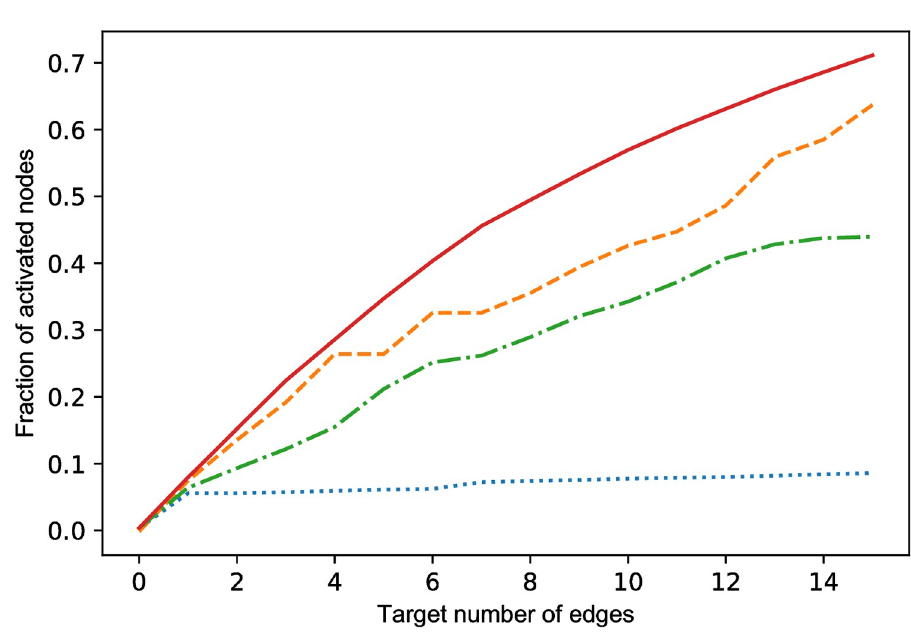
Fig 5. Performance of optimization algorithms in an network of education organizations of ± 250 nodes. On the x-axis the amount of selected edges is shown and on the y-axis the fraction of activated nodes. Legend: Solid red line: GLIM. Yellow dashed line: optimization using eigen vector centrality. Green dash-dotted line: optimization using outdegree. Blue dotted line: random edge selection.